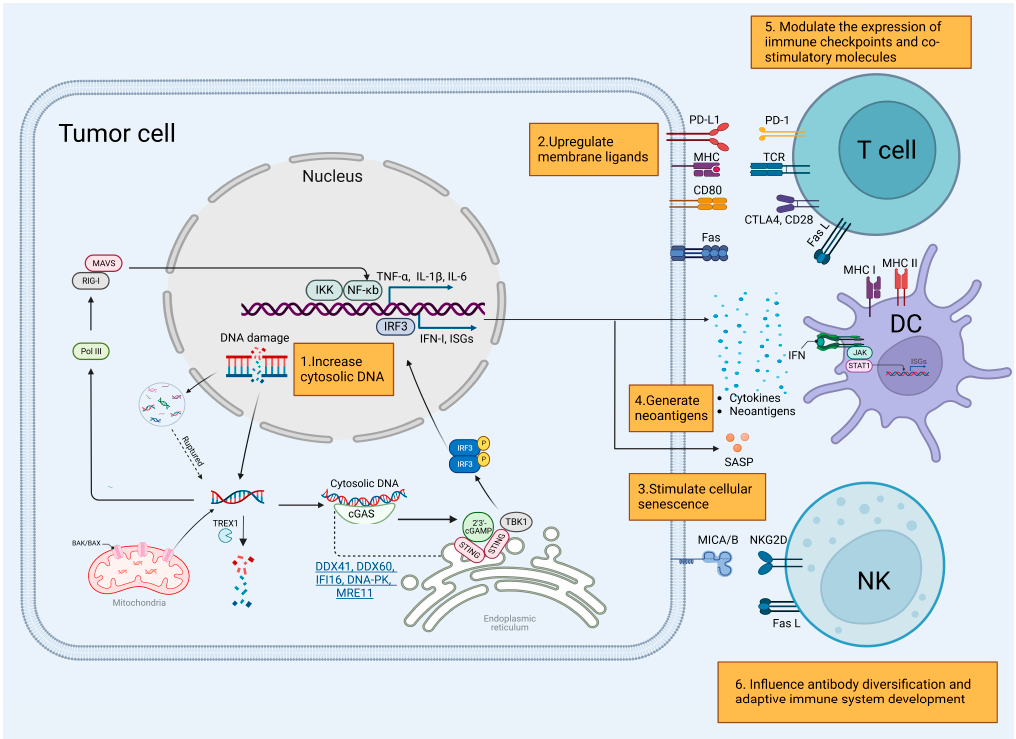
Figure 2. The interaction between DNA damage response (DDR) deficiency and immune